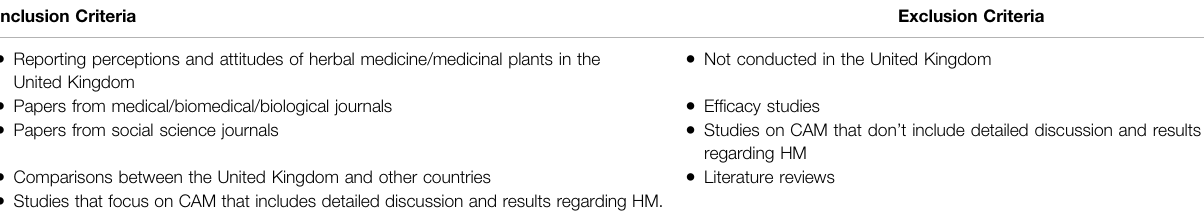
TABLE 1 | Inclusion and exclusion criteria.